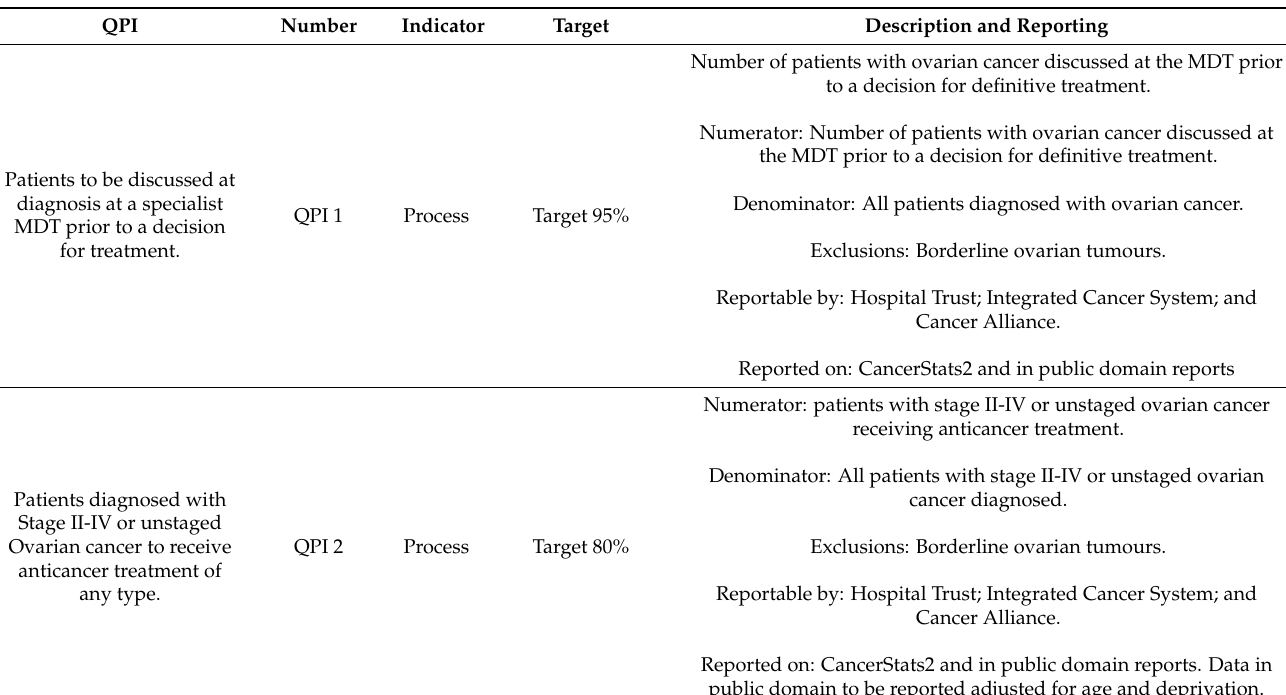
Table 1. Summary of QPI including numerators and denominators for QPI